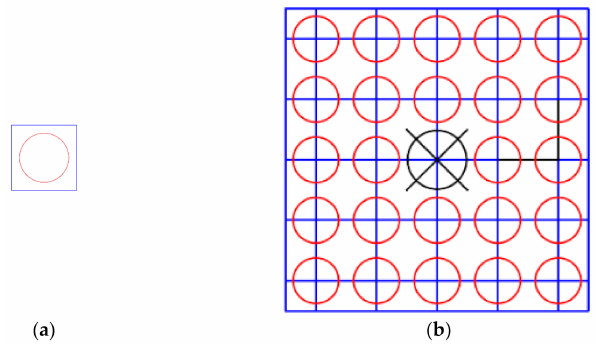
Figure 2. ( a ) CTF 1 × 1 design; ( b ) CTF 5 × 5